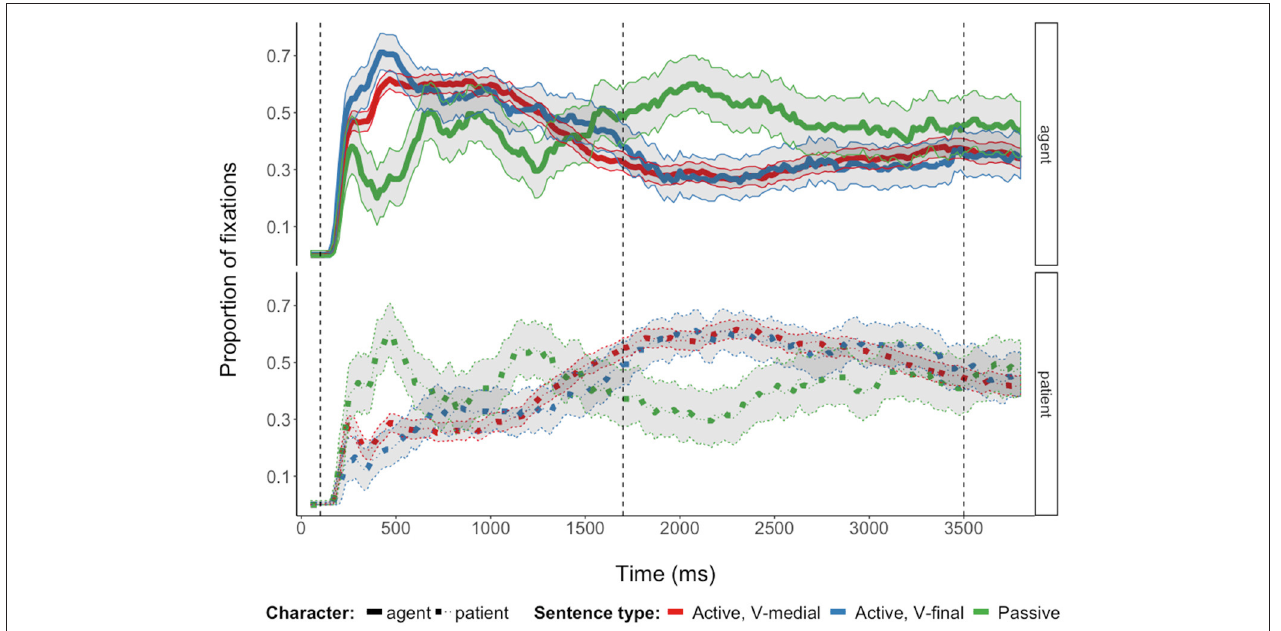
FIGURE 4 | Proportions of fixations to agents and patients during the production of three German sentence types. Proportions are based on fixations to agent and patient AOIs and to “whitespace” (Holmqvist et al., 2011) not covered by these AOIs. Ribbons indicate 95% multinomial confidence intervals (Sison and Glaz, 1995; Villacorta, 2012 ); vertical lines indicate analysis time